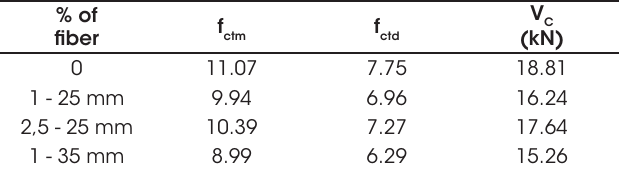
V values calculated for each volumetric C percentage of fibers